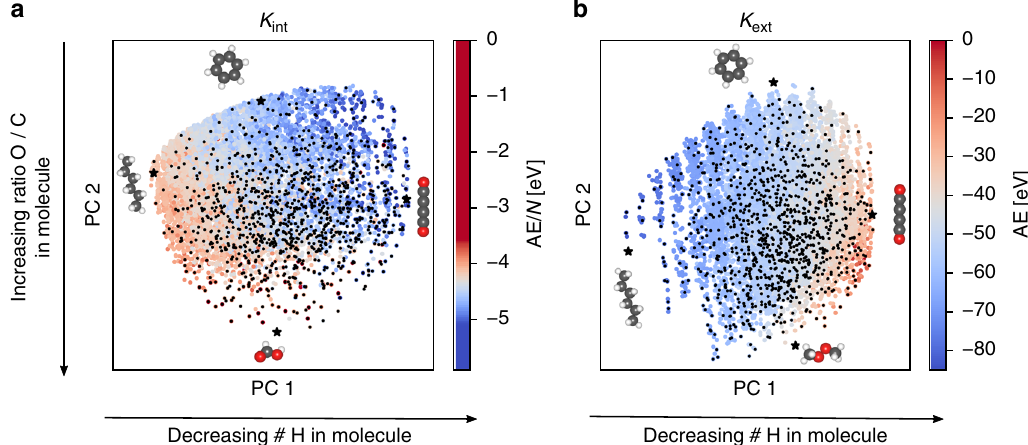
Fig. 3 Visualizing Rad-6 with Kernel Principal Component Analysis (kPCA). a kPCA based on an intensive kernel. b kPCA based on an extensive kernel. Points are colored according to the DFT atomization energy per atom in ( a ) and total atomization energy in ( b ). The arrows provide a qualitative interpretation of the principal component (PC) axes and small black dots indicate the FPS-selected training con fi gurations for a ML model with 1000 training molecules and using the corresponding distance criterion ( D int ( a ), D ext ( b )), see